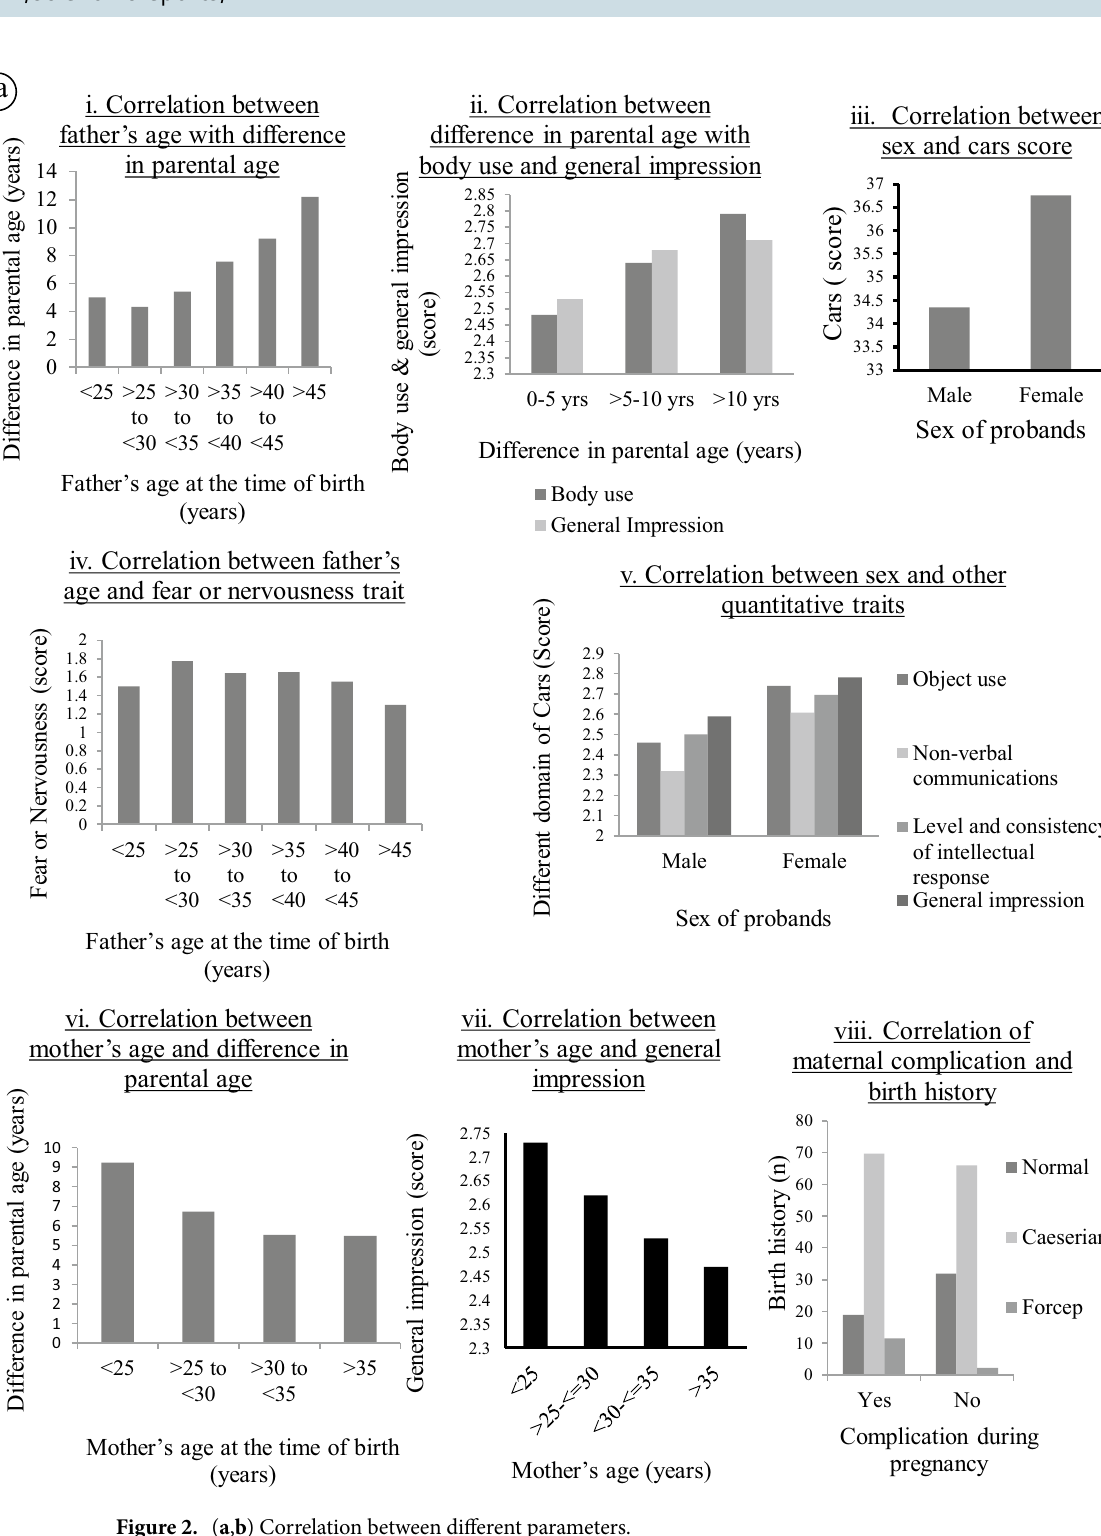
Figure 2. ( a , b ) Correlation between different